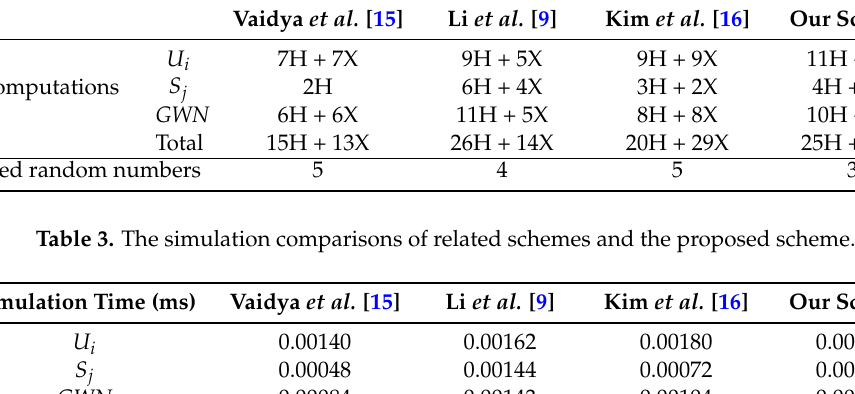
Table 2. The comparisons of related schemes and the proposed scheme. Vaidya et al. [15] Kim et al. [16] Our Scheme